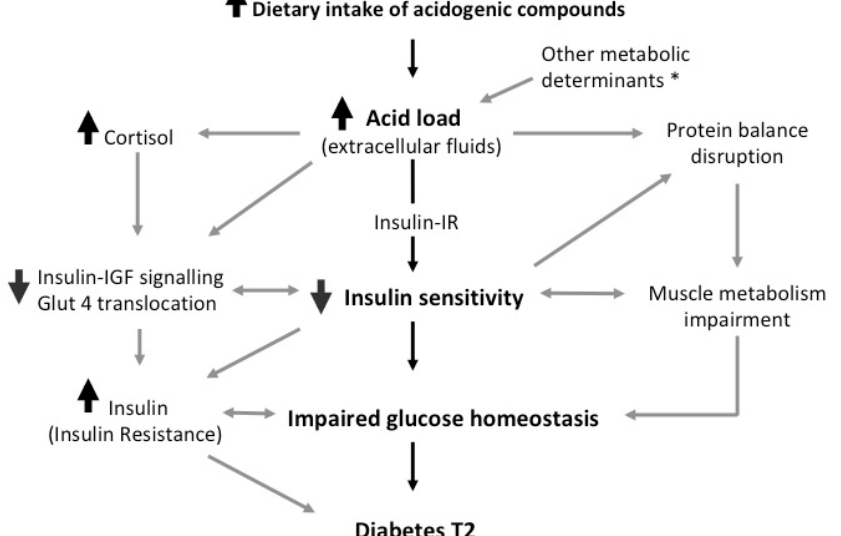
Figure 1. Synopsis of the possible underlying mechanism. Cortisol and other secondary mediators interfere with peripheral insulin activity via both impairing insulin receptor signal transduction and lowering the activation of intracellular insulin cascade [23,24]. The de-phosphorylation of the insulin receptor and key regulators, such as Akt [20,21], suppresses the translocation of GLUT4 in target tissues and downregulate the anabolic reactions propelled by insulin, including the inhibition of muscle protein breakdown [54,58,59]. This mechanism is likely to be independently promoted by pH imbalance secondary to acid load increase, and may account for the preservation of muscle mass when the acid load is low [63,64]. * Factors inducing the increase of acid load: catabolism end-products, metabolic conditions, kidney failure.